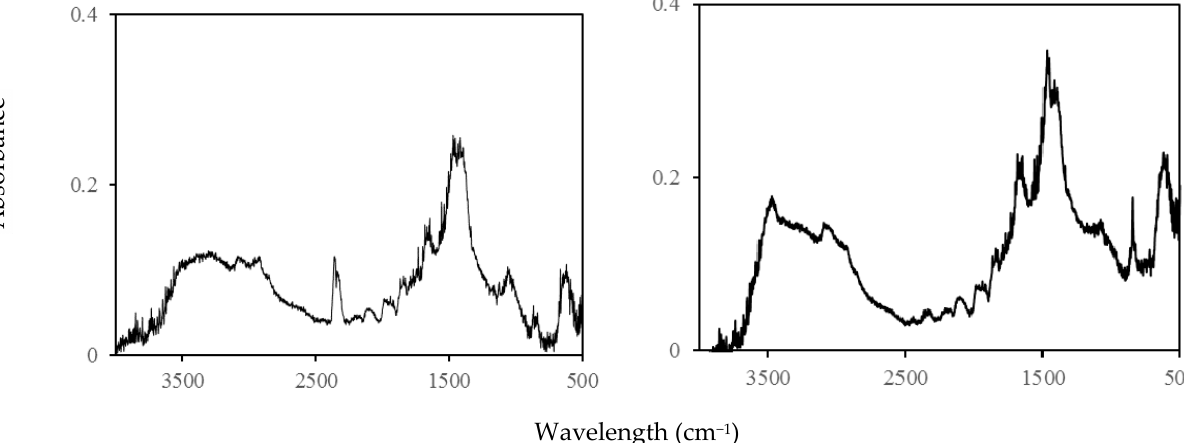
Figure 1. IR spectra from solid phase CDCl 3 extract of untreated (US) ( left panel ) and pre ‐ treated (AS) ( right panel ) sam ‐ ples.